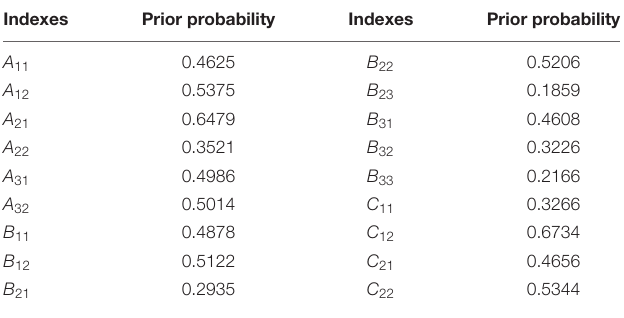
TABLE 2 | Prior probability of evaluation